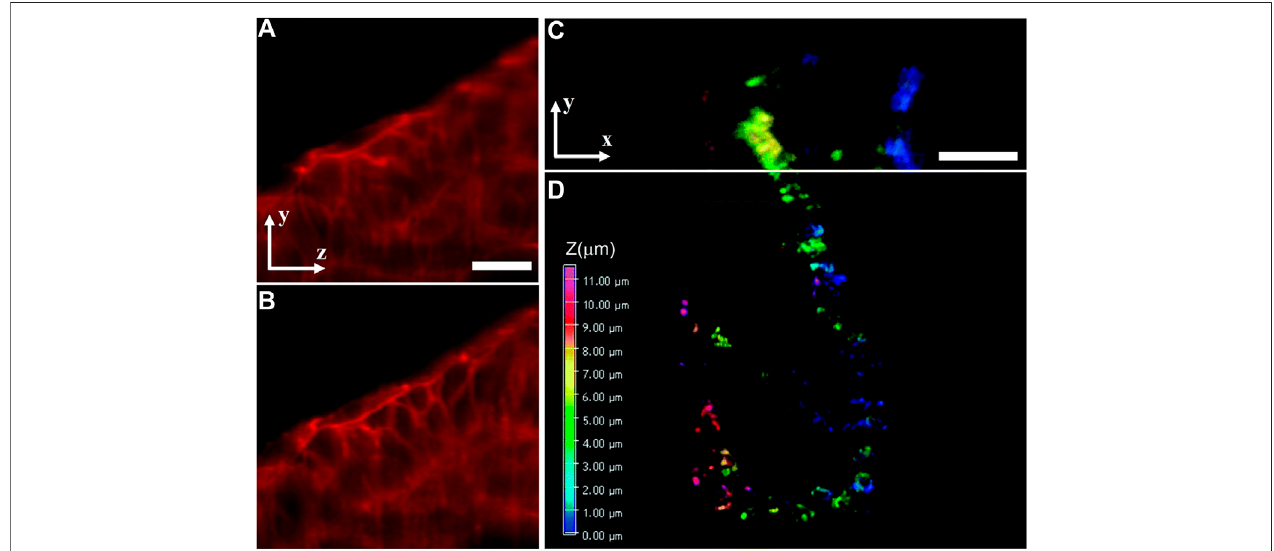
FIGURE11| Dual-lensLSFMmethods for3Dimagingofintracellularstructuresofthickbiologicalsamples. (A) and (B) SPIMimage (A) andSTED – SPIMimage (B) of the actin cytoskeleton in developing zebra fi sh embryos. Figures are modi fi ed with permission from Ref. 64. Copyright © 2011 Elsevier. (C) and (D) 3D images of mitochondrial structures of fi xed HeLa cell taken with two-photon three-axis DSLM (C) and its SOFI counterpart (D) . Figures are modi fi ed with permission from Ref. 66. Copyright © 2016 The Royal Society of Chemistry. Scale bars: 20 μ m (A) and 5 μ m (C) .